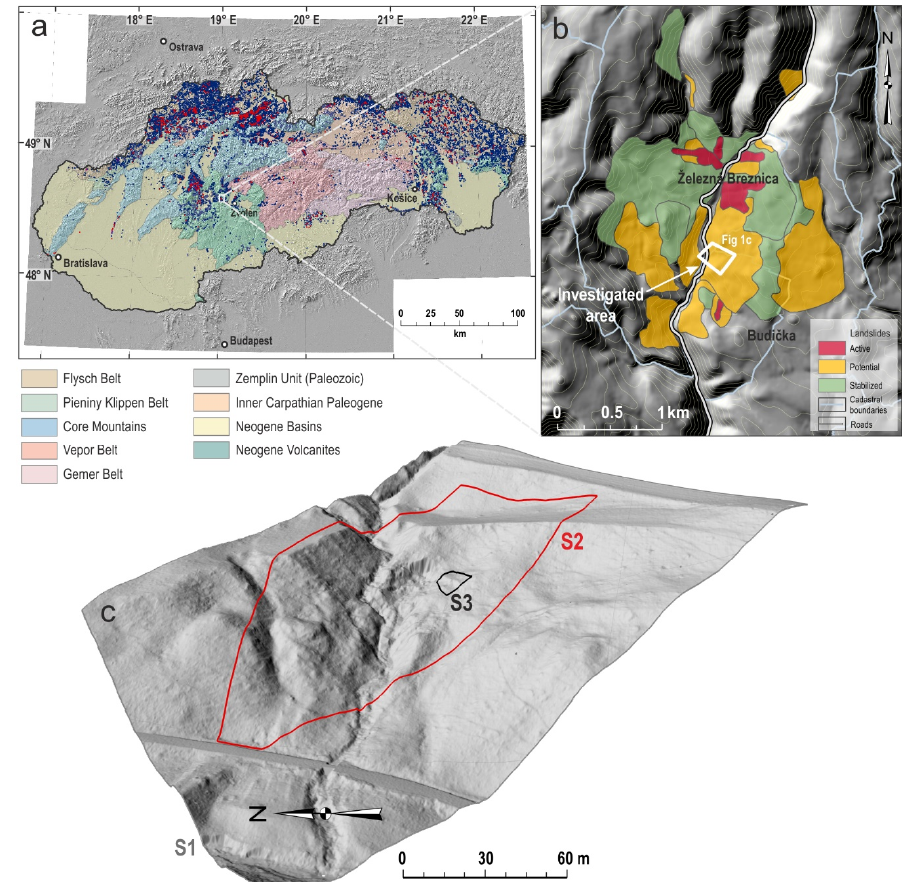
Figure 1. ( a ) Location of the study area: Map of main geological units of Slovakia with distribution of slope failures (modified after [25,27,28]). Active and stable slope failures are depicted by red and blue colors, respectively. The location of the study area is shown by a white polygon. ( b ) Shaded relief map of the investigated area near Železna Breznica village. Landslides registered in national database (modified after [28]) and the position of the investigated area are shown. ( c ) Detailed view on the studied slope. S1, S2, and S3 polygons are related to the light detection and ranging (LiDAR), remotely piloted aircraft system (RPAS), and close-range photogrammetry (CRP) survey technologies,